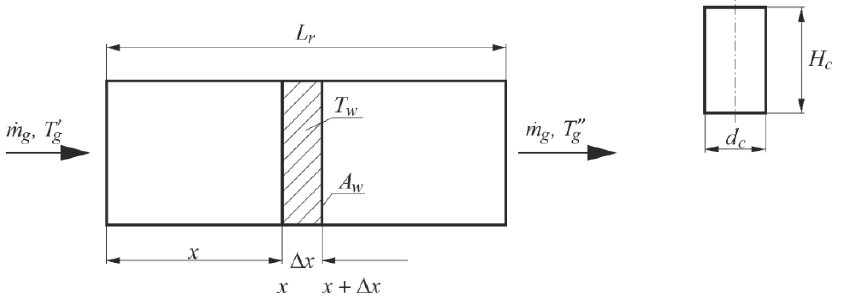
Figure 5. Heat accumulator with a finite volume of a Δ x thickness.